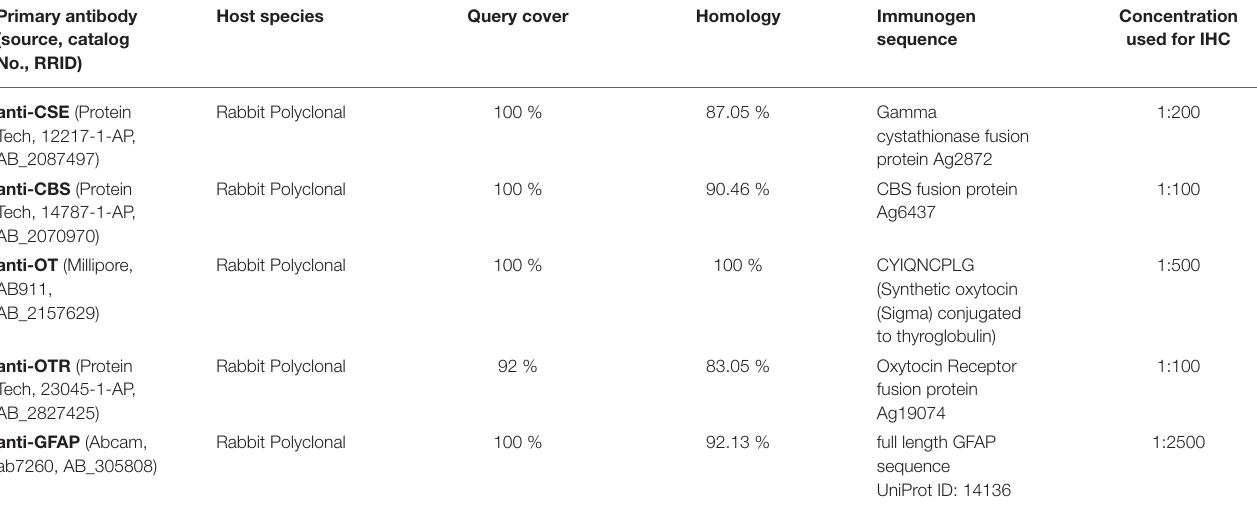
Concentration sequence used for